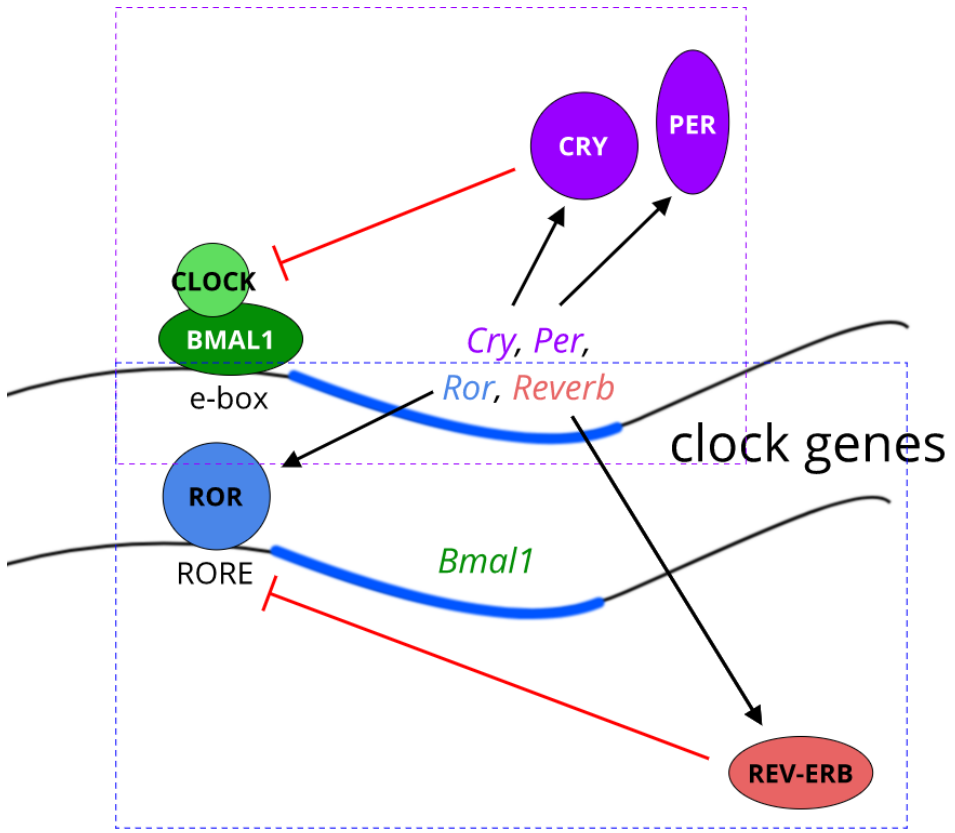
Figure 1. Cartoon of the core molecular clock. Simplified illustration of the core molecular clock comprising: the circadian locomotor output cycles kaput (CLOCK), brain muscle Arnt-like protein 1, Arntl (BMAL1) and the genes Cryptochrome1 / 2 (CRY) / Period1 / 2 / 3 (PER) transcription-translation feedback loop (TTFL) (purple dashed box; and the regulatory REV-ERB / ROR limb (blue dashed